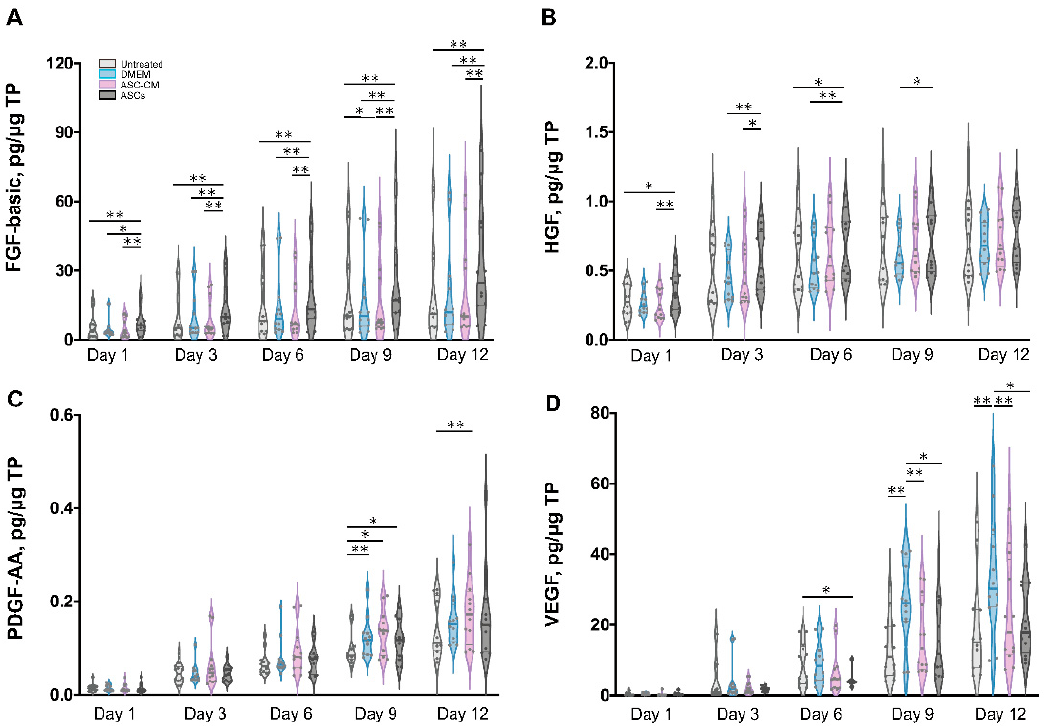
Figure 6. Quantification of growth factors in skin extracts. The levels of FGF-basic ( A ), HGF ( B ), PDGF-AA ( C ), and VEGF ( D ) were measured in samples collected from six donors at different time points. Each sample was measured in duplicate. The values for the different groups were normalized to the respective sample total protein and reported as the cumulative amount of analyte versus time. The thin gray lines show the 75th percentile (upper) and 25th percentile (lower); the thicker bars within the violin plots indicates the median. Statistical analysis was done using the Wilcoxon signed-rank test. * p < 0.05, ** p <